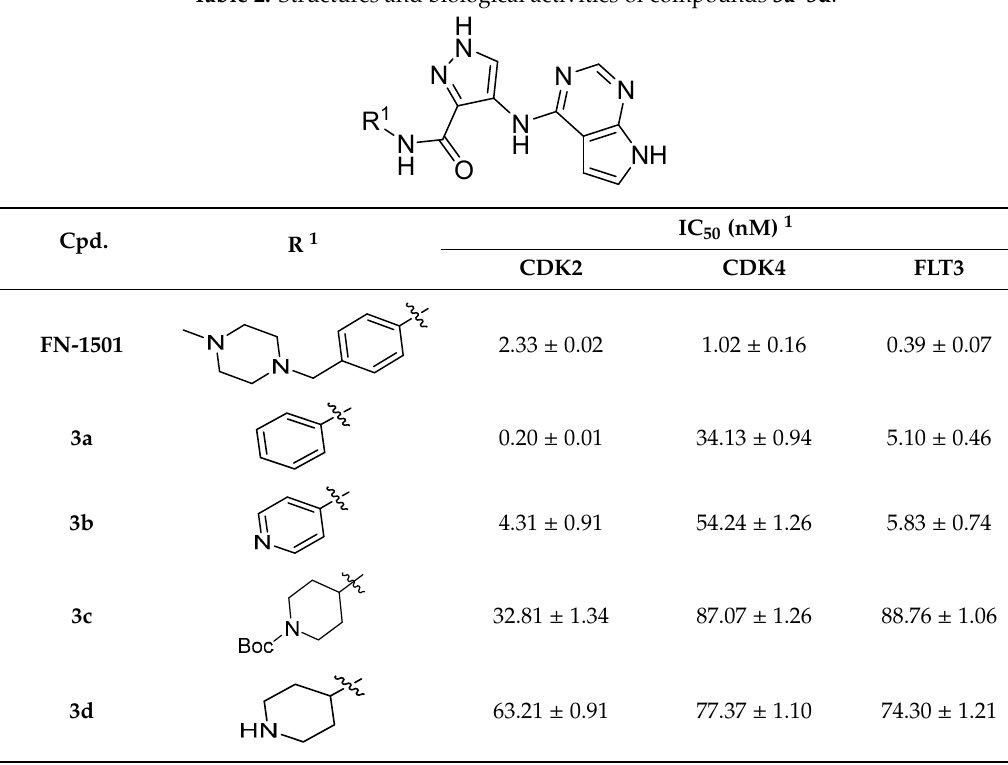
Table 3. Structures and biological activities of compounds 8a –